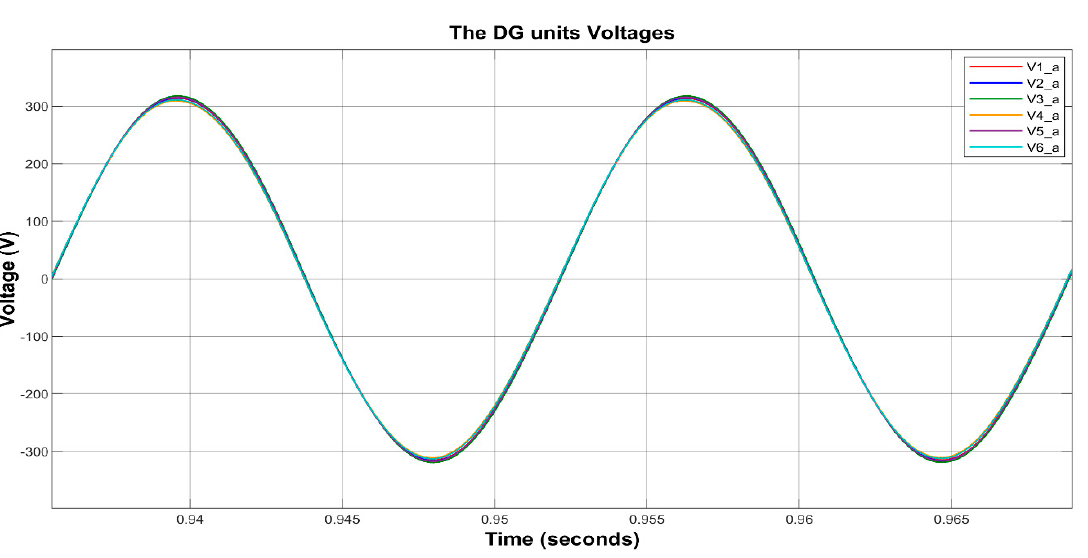
Figure 10. The DG units’ magnitude of phase a of output voltages for Case 1.